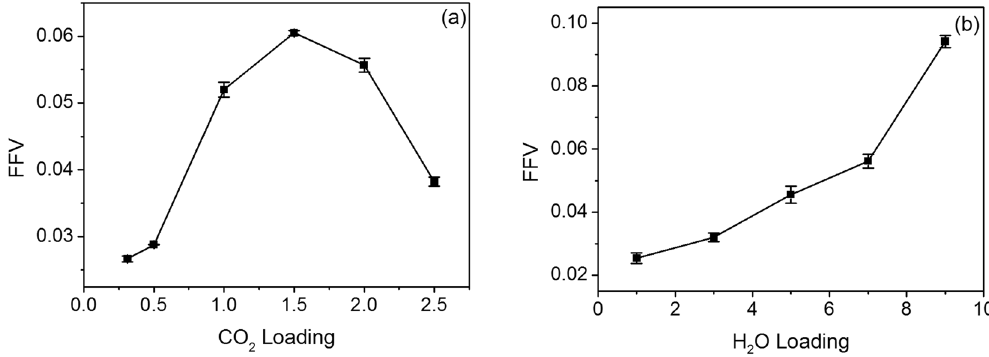
Figure 3. Fractional free volume (FFV) dependence on: ( a ) CO 2 loading; ( b ) H 2 O